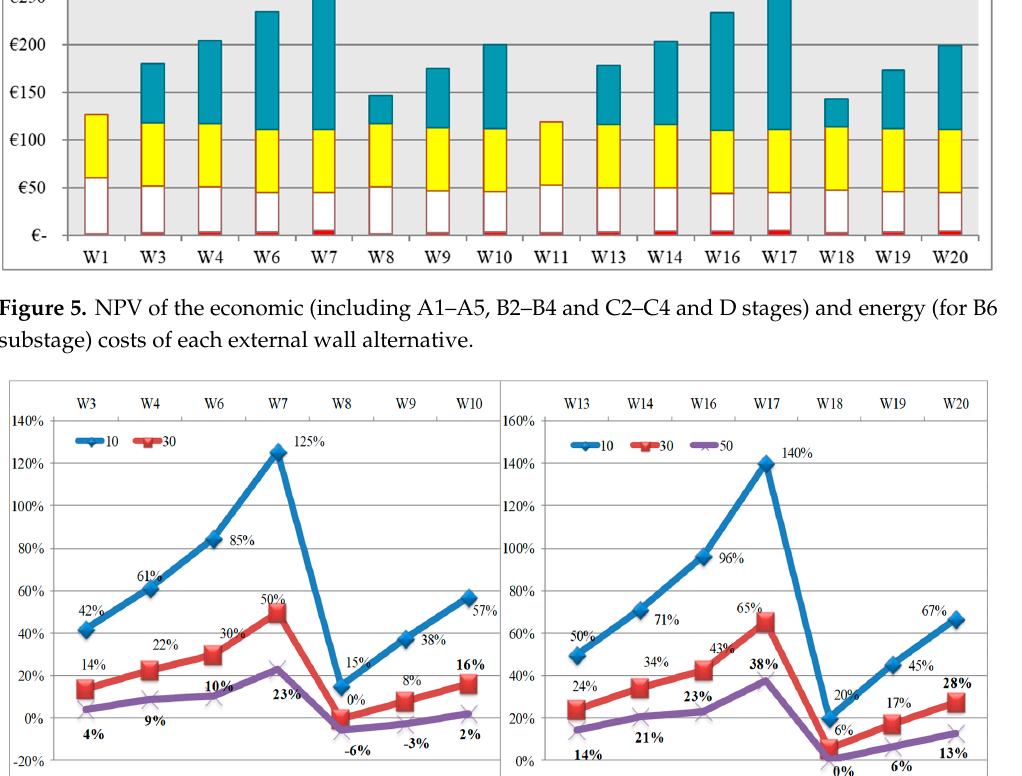
Figure 6. Difference between the NPV of the economic (including A1–A5, B2–B4 and C2–C4 and D stages) and energy (B6 substage) costs of each external wall alternative and the NPV of reference solution (W1, for single-leaf walls, at left; W11, for cavity walls, on the right), considering different consumption patterns for the use stage (providing 10%, 30% or 50% of the energy needs).